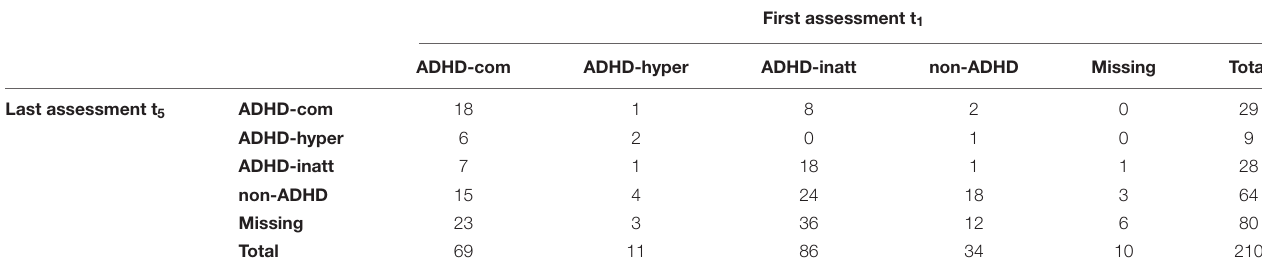
TABLE 2 | Distribution of attention-deficit/hyperactivity disorder (ADHD) presentation at the first t 1 and last t 5 assessment based on self-reported symptom